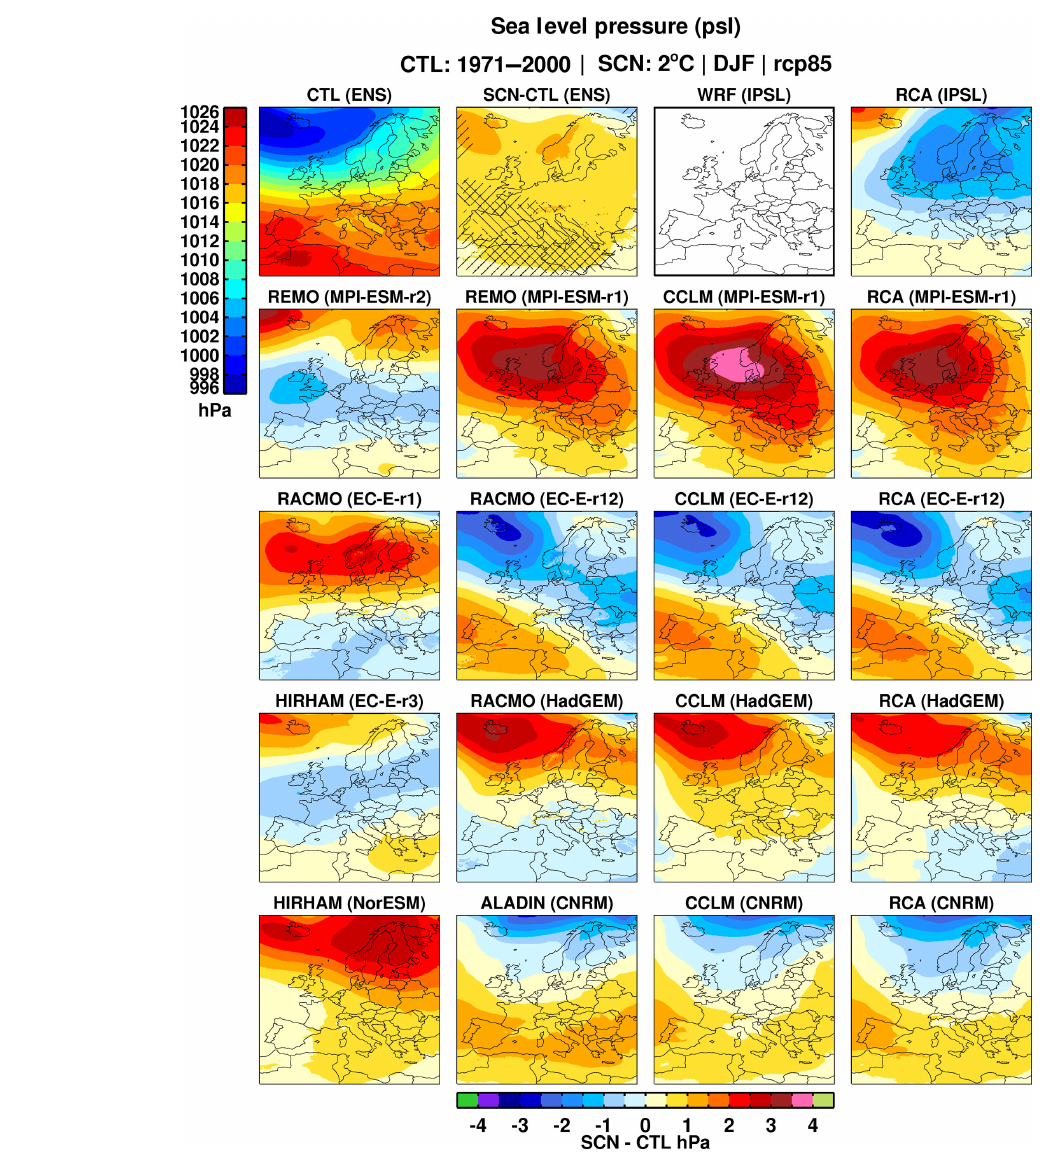
Figure 2. Winter (DJF) mean sea level pressure in the reference period (ensemble mean in the uppermost left panel) and its change in 17 RCM simulations in Table 1 (individual runs in upper right panel and all other rows) for the + 2 ◦ C of warming level (SWL2). As MSLP data for the WRF simulation are missing, that panel is left blank. Hatching in the ensemble mean signal (second upper panel from the left) represents areas where at least 14 of the 18 ensemble members agree on the sign of change. Cross-hatching indicates that there is agreement on the sign of change and that the signal-to-noise ratio is larger than